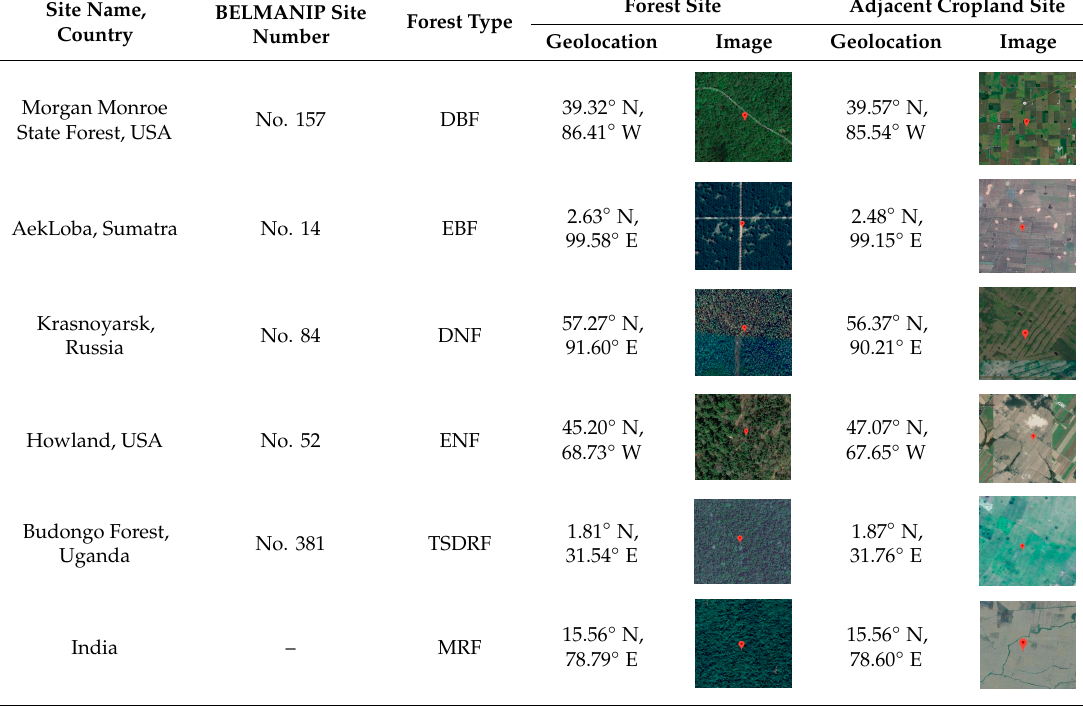
with an opening downward during the maturity period, with notable variations in NDVI values, which significantly differ from those of forests. The 𝑁𝐷𝑉𝐼 (cid:3014)(cid:3028)(cid:3047)(cid:3048)(cid:3045)(cid:3036)(cid:3047)(cid:3052) _ (cid:3014)(cid:3032)(cid:3028)(cid:3041) of forests is generally higher than that of crops, while its 𝑁𝐷𝑉𝐼 (cid:3014)(cid:3028)(cid:3047)(cid:3048)(cid:3045)(cid:3036)(cid:3047)(cid:3052) _ (cid:3020)(cid:3005) is much smaller. For forests, the 𝑁𝐷𝑉𝐼 (cid:3014)(cid:3028)(cid:3047)(cid:3048)(cid:3045)(cid:3036)(cid:3047)(cid:3052) _ (cid:3014)(cid:3032)(cid:3028)(cid:3041) of all six sites is above 0.8, while 𝑁𝐷𝑉𝐼 (cid:3014)(cid:3028)(cid:3047)(cid:3048)(cid:3045)(cid:3036)(cid:3047)(cid:3052) _ (cid:3020)(cid:3005) is mostly around 0.02, with the maximum value not exceeding 0.04. For neighboring crops, 𝑁𝐷𝑉𝐼 (cid:3014)(cid:3028)(cid:3047)(cid:3048)(cid:3045)(cid:3036)(cid:3047)(cid:3052) _ (cid:3014)(cid:3032)(cid:3028)(cid:3041) is around 0.7, with the maximum value being no more than 0.76, while most SD values are above 0.05, and it is even greater than 0.10 for DBF, ENF and MRF. For DNF, although its NDVI curve is similar to that of neighboring cropland, differences are still observed for the two features compared to that of cropland. 3.2. Contrast of Mean and SD of NDVI during the Vegetation Maturity Period between Forests and Herbaceous Vegetaiton Figure 4 displays maps of 𝑁𝐷𝑉𝐼 (cid:3014)(cid:3028)(cid:3047)(cid:3048)(cid:3045)(cid:3036)(cid:3047)(cid:3052) _ (cid:3014)(cid:3032)(cid:3028)(cid:3041) and 𝑁𝐷𝑉𝐼 (cid:3014)(cid:3028)(cid:3047)(cid:3048)(cid:3045)(cid:3036)(cid:3047)(cid:3052) _ (cid:3020)(cid:3005) in 2010 for the four MODIS tiles, including h27v05, h25v07, h11v10 and h11v04. The results demonstrate that these two features present notable differences between forest and non-forest at regional scale, according to the true color imagery in Figure 1. For the forest areas (dark green in RGB images in Figure 1), the value of 𝑁𝐷𝑉𝐼 (cid:3014)(cid:3028)(cid:3047)(cid:3048)(cid:3045)(cid:3036)(cid:3047)(cid:3052) _ (cid:3014)(cid:3032)(cid:3028)(cid:3041) is generally above 0.8, and 𝑁𝐷𝑉𝐼 (cid:3014)(cid:3028)(cid:3047)(cid:3048)(cid:3045)(cid:3036)(cid:3047)(cid:3052) _ (cid:3020)(cid:3005) is below 0.02. For tropical rainforest (h11v10) with a dense canopy, the 𝑁𝐷𝑉𝐼 (cid:3014)(cid:3028)(cid:3047)(cid:3048)(cid:3045)(cid:3036)(cid:3047)(cid:3052) _ (cid:3014)(cid:3032)(cid:3028)(cid:3041) is above 0.85 or even 0.9, while 𝑁𝐷𝑉𝐼 (cid:3014)(cid:3028)(cid:3047)(cid:3048)(cid:3045)(cid:3036)(cid:3047)(cid:3052) _ (cid:3020)(cid:3005) is around 0.01. In contrast, for crops and grasses (light green in RGB images in Figure 1), the 𝑁𝐷𝑉𝐼 (cid:3014)(cid:3028)(cid:3047)(cid:3048)(cid:3045)(cid:3036)(cid:3047)(cid:3052) _ (cid:3014)(cid:3032)(cid:3028)(cid:3041) is generally below 0.8, and the SD value is above 0.035. For sparsely vegetated areas (gray in RGB images in Figure 1), such as the central part of h25v07, upper left corner of h11v04 and lower left zone along the forest areas of h11v10, the 𝑁𝐷𝑉𝐼 (cid:3014)(cid:3028)(cid:3047)(cid:3048)(cid:3045)(cid:3036)(cid:3047)(cid:3052) _ (cid:3014)(cid:3032)(cid:3028)(cid:3041) is usually below 0.6, which is much lower than that of dense vegetation. Significant differences of the two features between forest and other landcover types could contribute to forest classification. For tropical regions, including h25v07 and h11v10, the 𝑁𝐷𝑉𝐼 (cid:3014)(cid:3028)(cid:3047)(cid:3048)(cid:3045)(cid:3036)(cid:3047)(cid:3052) _ (cid:3020)(cid:3005) of herbaceous vegetation is generally lower than that in middle and high latitudes, but its 𝑁𝐷𝑉𝐼 (cid:3014)(cid:3028)(cid:3047)(cid:3048)(cid:3045)(cid:3036)(cid:3047)(cid:3052) _ (cid:3014)(cid:3032)(cid:3028)(cid:3041) value is still significantly lower than that of forests. Combining the two features can effectively distinguish forest and herbaceous vegetation in these